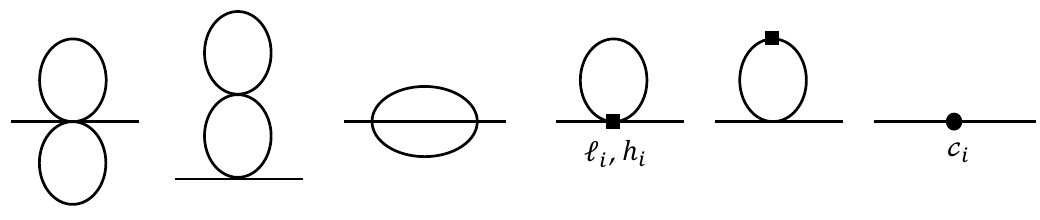
Figure 1 . One-particle-irreducible diagrams for the axion and pion 2-point functions at NNLO. graphs from the O ( p 6 ) Lagrangian. 8 At (cid:11) (cid:31) NNLO